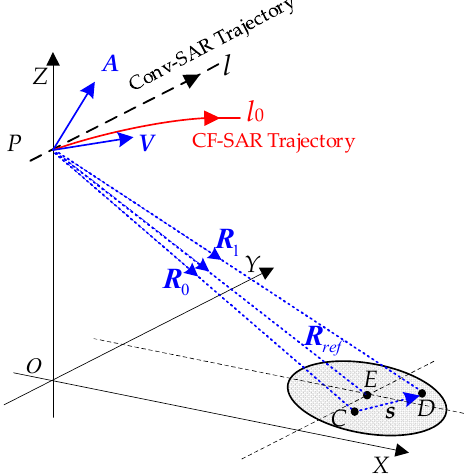
Figure 3. Geometry of monostatic CF-SAR with general configurations.